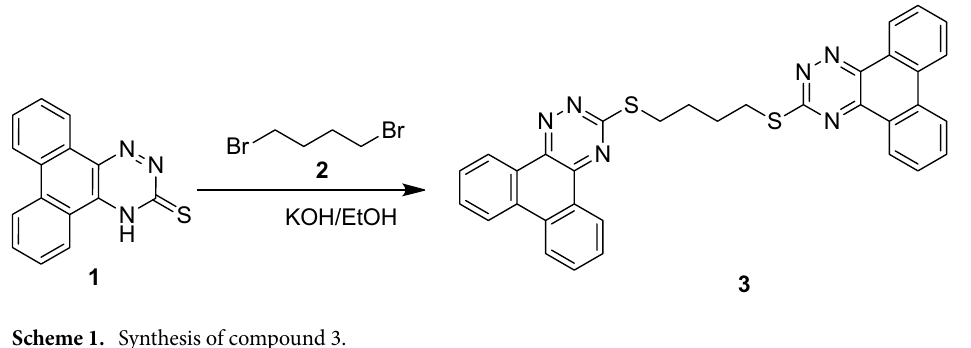
Scheme 1. Synthesis of compound